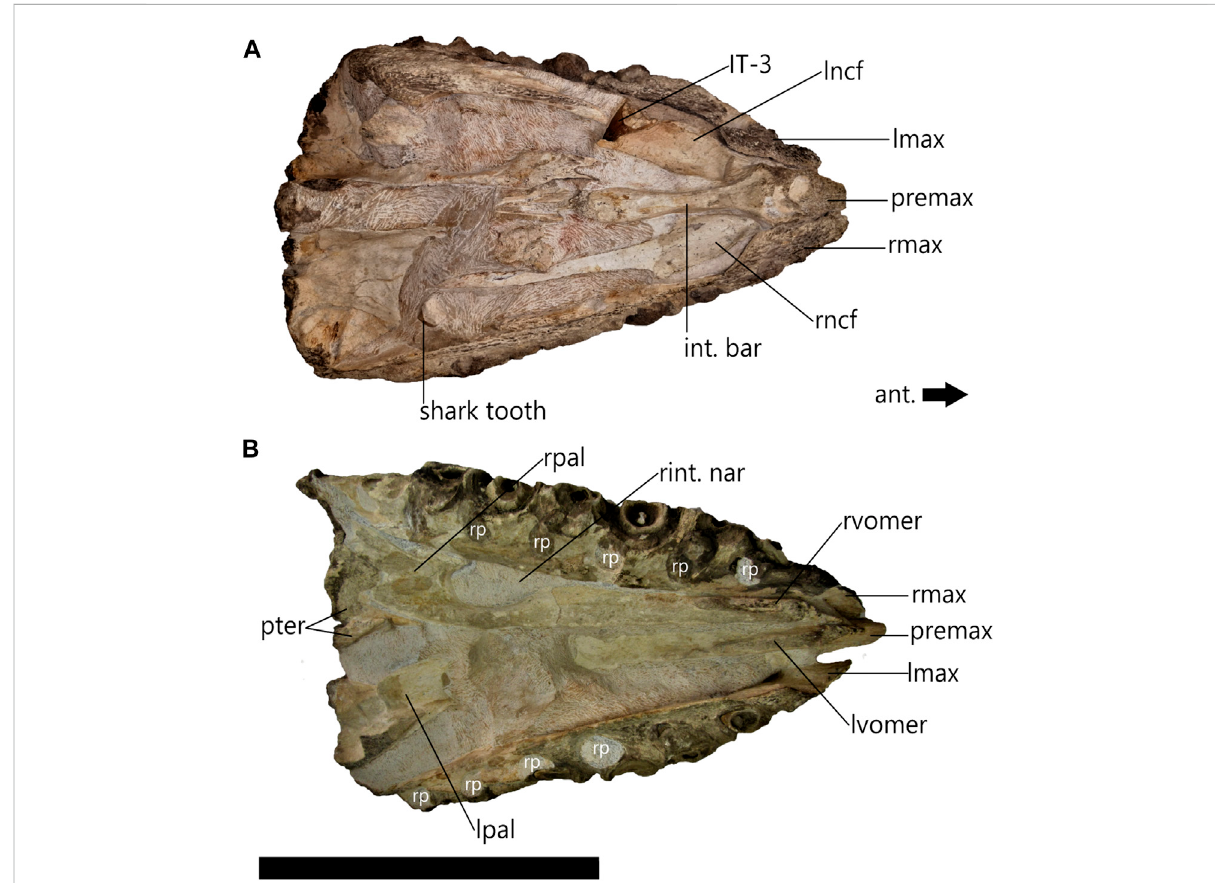
FIGURE 4 cf. Prognathodon muzzle unit (CGP/1/2265) muzzle unit in dorsal (A) and ventral (B) view with anterior (ant.) end of muzzle unit indicated by directional arrow. Note: fragmentary Squalicorax pristodontus tooth location in matrix (shark tooth). Abbreviations: internarial bar (int. bar ) ; isolated tooth3(IT-3);leftmaxilla(lmax);leftnasalcavity fl oor(lncf);leftpalatine(lpal);leftvomer(lvomer);premaxilla(premix);pterygoids(pter);rightmaxilla (rmax); right nasal cavity fl oor (rncf); right palatine (rpal); resorption pits (rp); right vomer (rvomer). Scale bar = 300